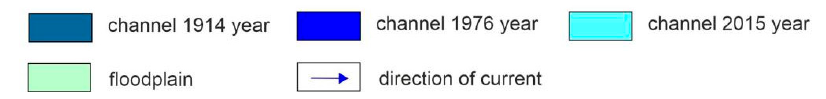
Figure 9. Comparison of the channel plans of the Irkut river in three time sections.